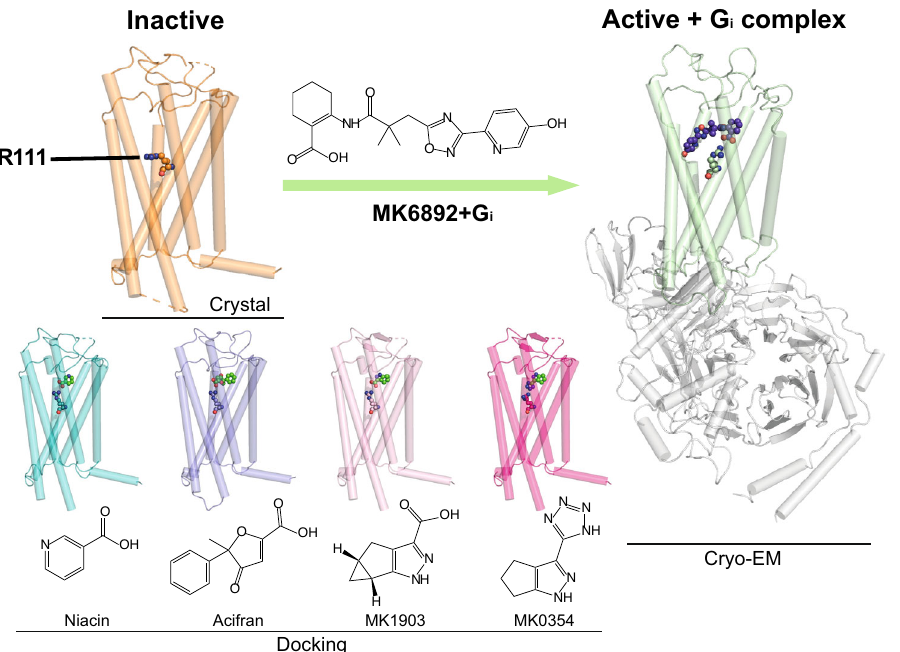
Fig. 4 | HCA2 key residue with ligands recognition. Key residue and ligands are shownassticksandspheres.InactivestateHCA2inorangecolor,activestatecryo- EM structure of HCA2 with MK-6892 and G i complex in green and grey,